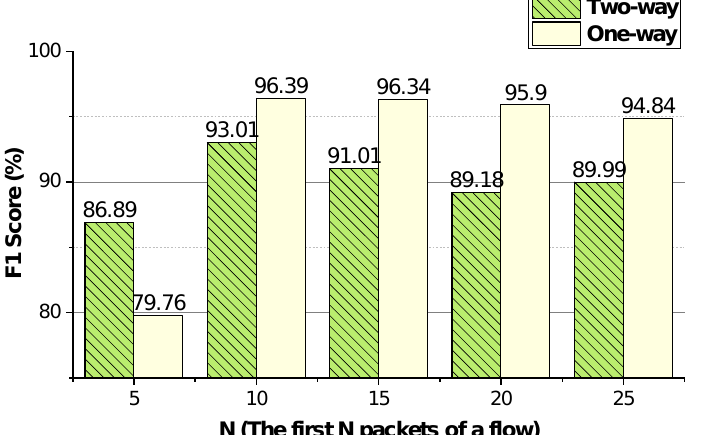
Figure 3. The Shadowsocks traffic detection performance of the method using the two-way and one-way packet size sequences of the flow, respectively.